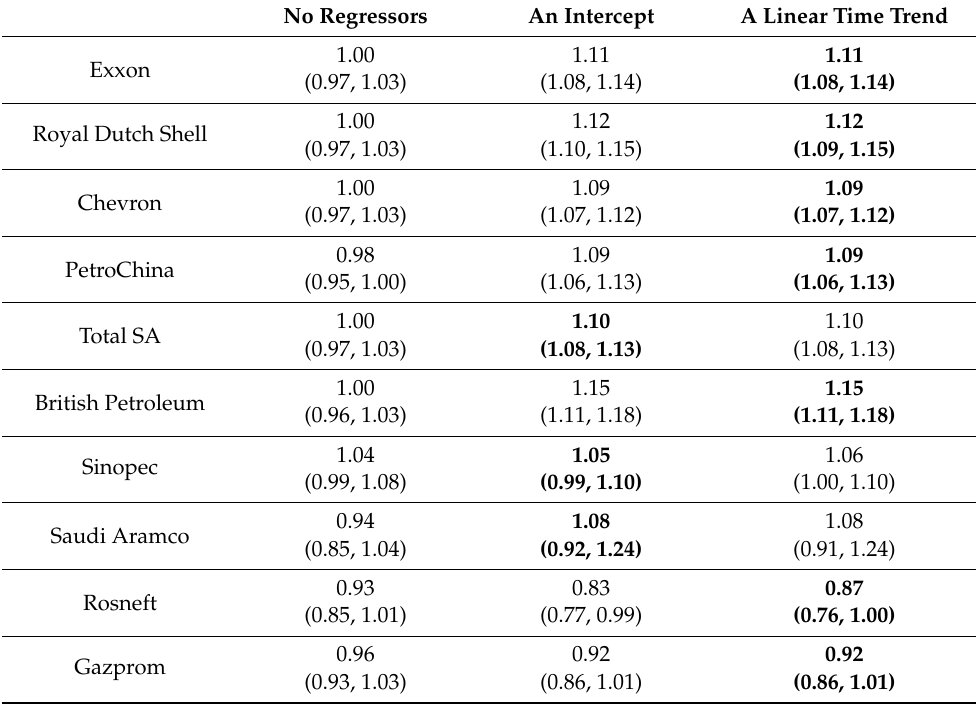
Table 2. Estimates of d for the betas with white